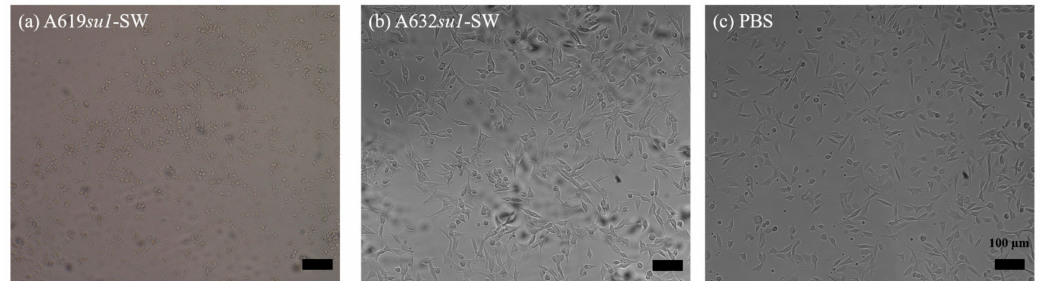
Figure 3. Bright-field micrographs of NIH3T3 cells treated with ( a ) A619 su1 -SW, ( b ) A632 su1 -SW, or ( c ) PBS. Scale bar represents 100 µ m in all